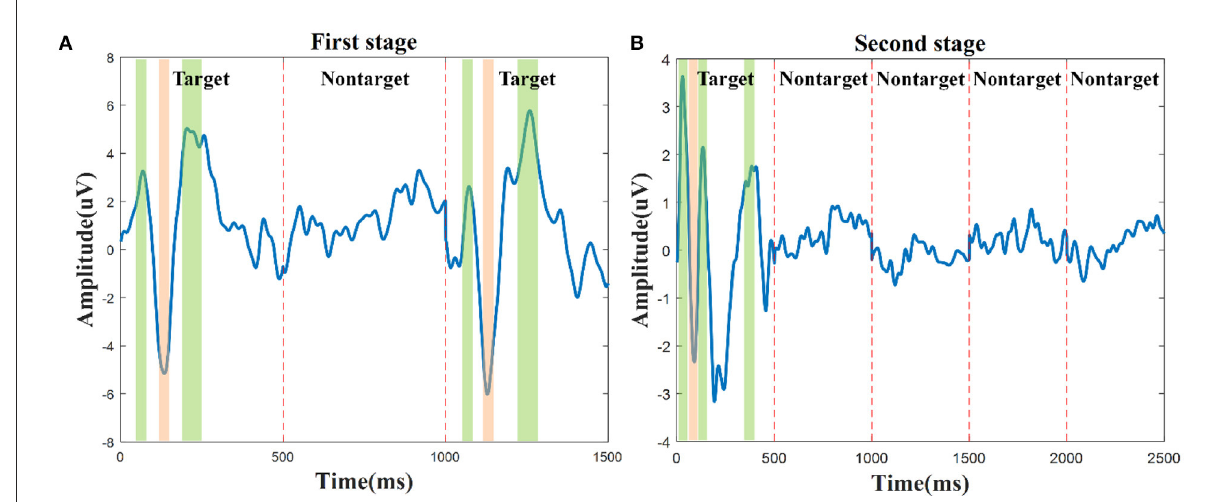
FIGURE4 The grand average of target and nontarget signals during the character A spelling process for S10 was recorded on channel P4. (A) The mVEP of the group characters A-E in the first stage, P1, N2, and P2 are the three main target components. (B) The audio-assisted visual ERP components of character A in the second stage, P1, N2, P2, and P300 are the main target components.